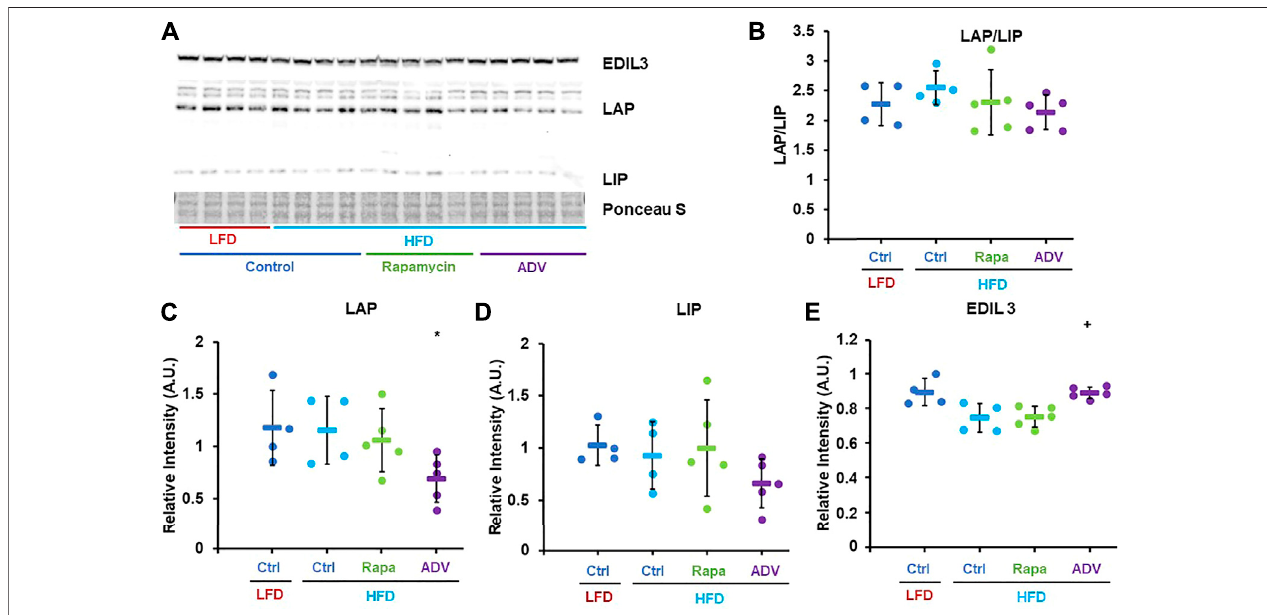
FIGURE 5 | Adefovir dipivoxil increases expression of C/EBP- β LAP and EDIL3. (A) Representative western blot image against EDIL3, C/EBP- β (LAP and LIP isoforms) and GAPDH. (B – E) Densitometric analysis of the western blot in panel (A) Circles: individual animals, bars: average + - standard deviation. *: p < 0.05 vs LFD control, **: p < 0.01 vs LFD control, +: p < 0.05 vs HFD control, ++: p < 0.01 vs HFD